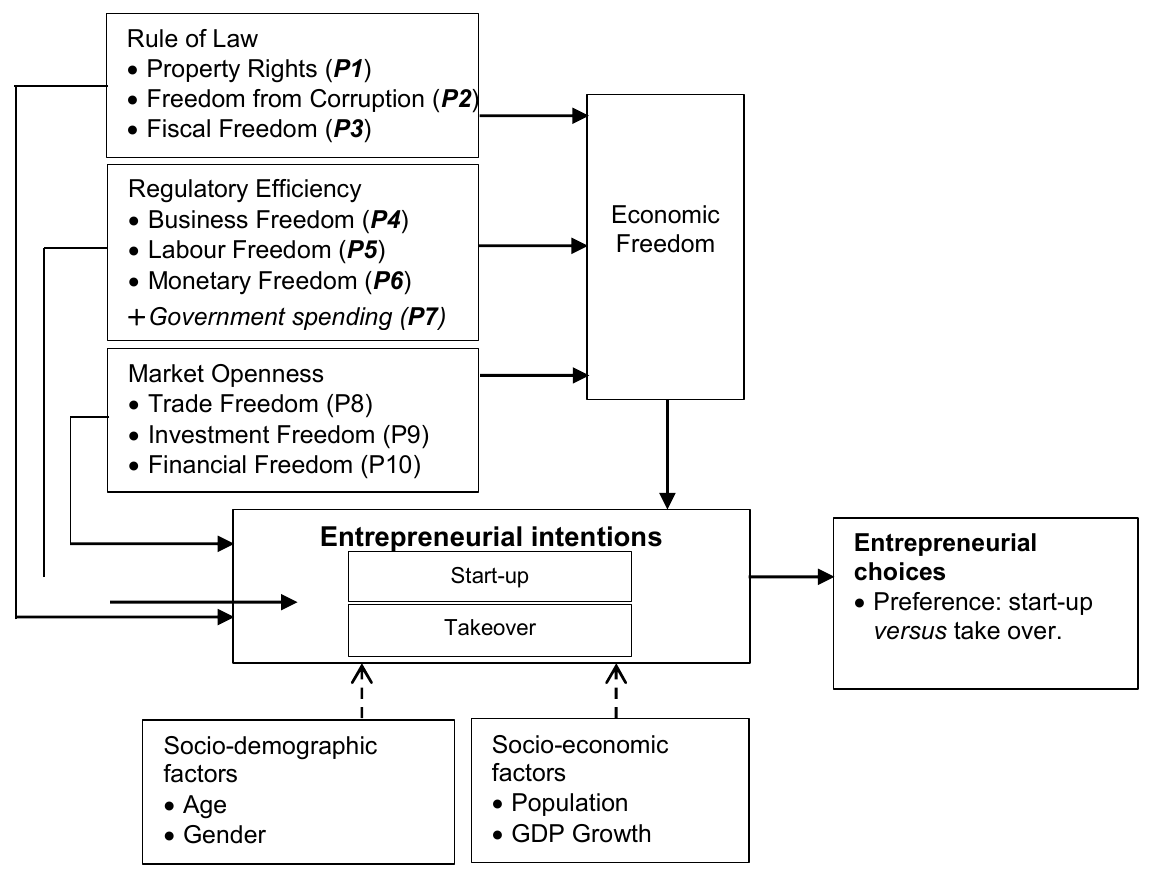
Figure 1. A model of the influence of institutional environment on the entrepreneurial intentions. Table 2 reports a summary of the descriptive statistics of the variables as part of the model examined, covering dependent, independent, and control variables across the 119,446 observations considered.